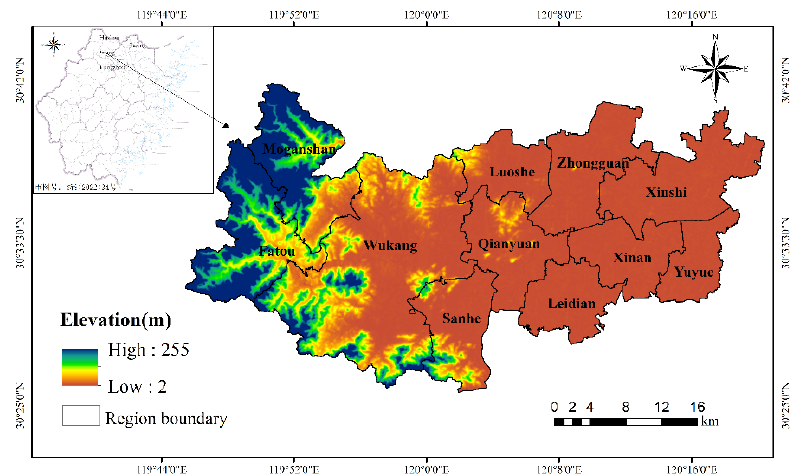
Figure 1. Location of Deqing and the DEM for the region. Table 1. Research datasets used in this